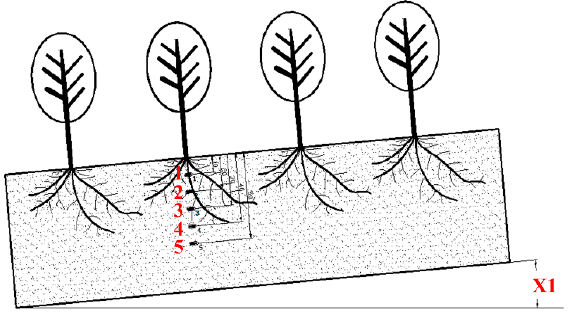
Figure 3. Sensor layout. TRIME PICO 64 soil moisture sensors were arranged along the roots of tea plants. Numbers 1–5 represent the sensors located at depths of 10.0 cm, 20.0 cm, 30.0 cm, 40.0 cm, and